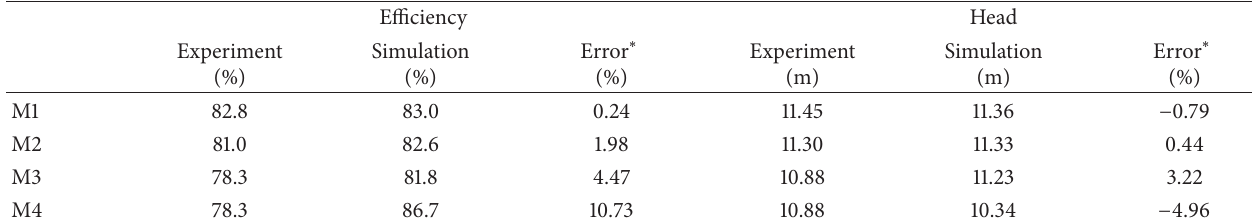
Table 3: Comparison of numerical results with experiment results of the pump performance.